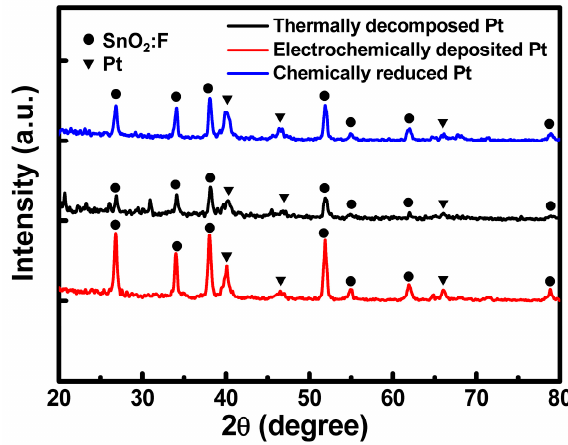
Figure 2. SEM images of ( a ) the Pt electrode fabricated through thermal decomposition; ( b ) the Pt electrode fabricated through electrochemical deposition; and ( c ) the Pt electrode fabricated through chemical reduction.